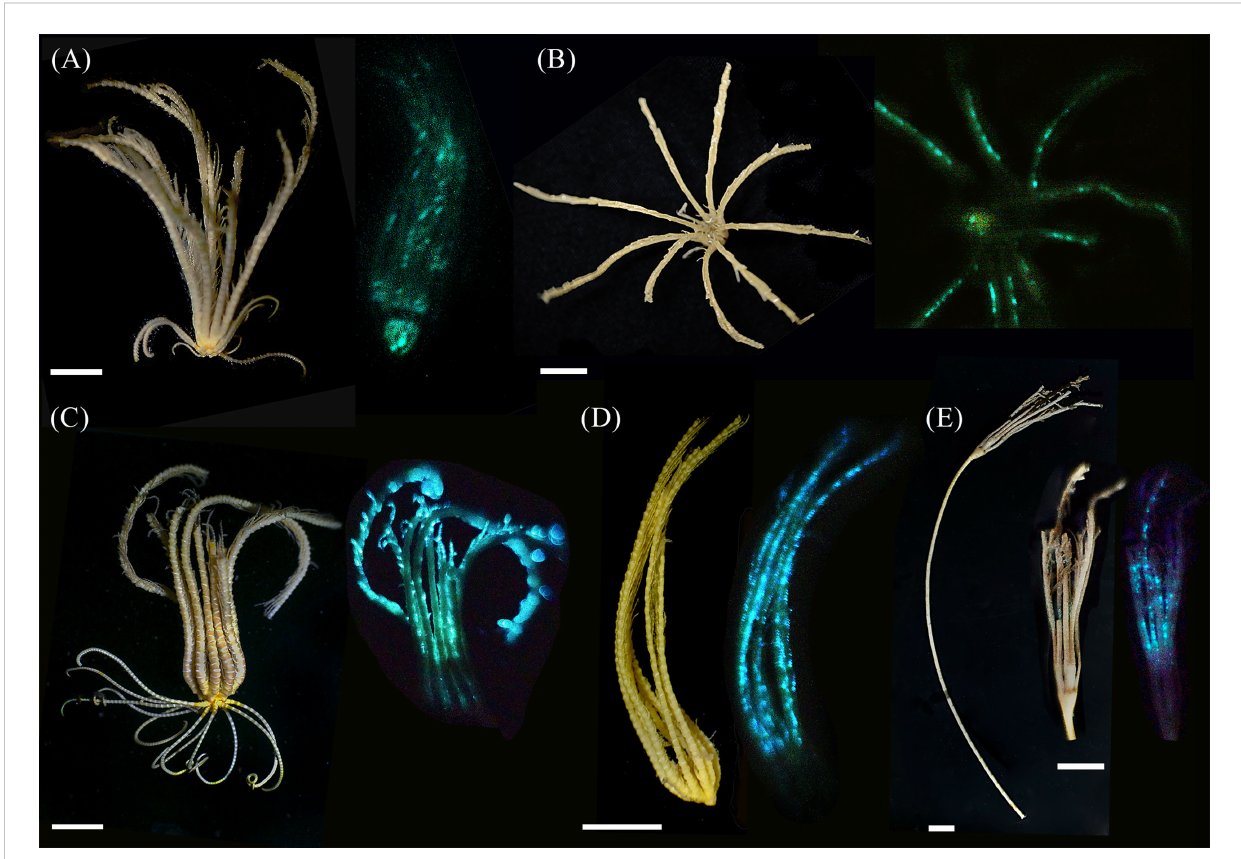
FIGURE 1 Photography of daylight (left) and light-emitting (right) crinoids. (A) Lateral view of Stiremetra breviradia and (B) oral view of S. breviradia (both KCL stimulation); (C) whole specimen of Thalassometra cf. gracilis and (D) closer view of T .cf gracilis arms (KCL stimulation); (E) specimen